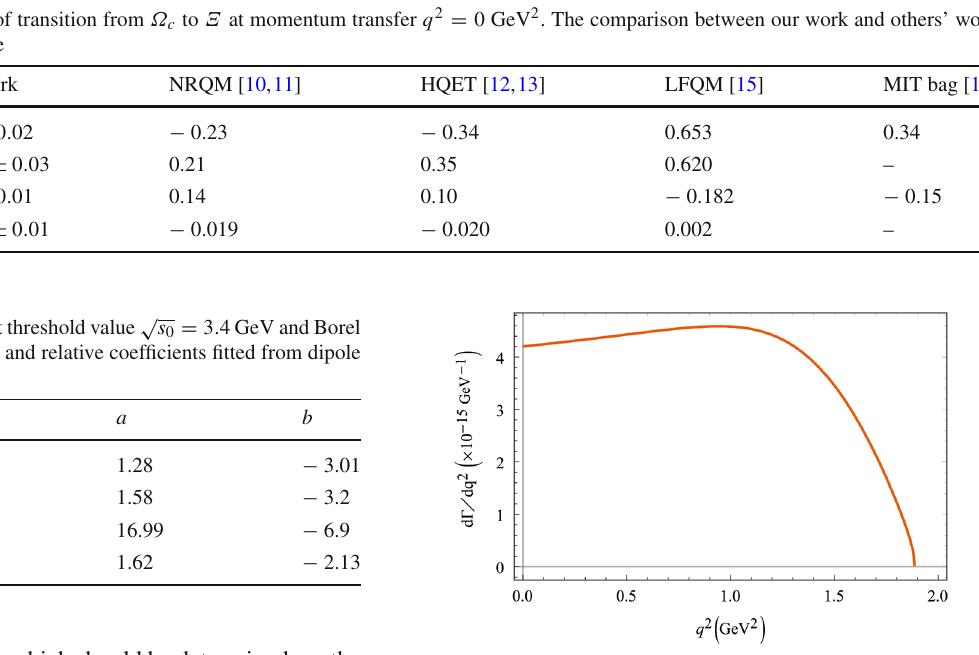
Table 1 The form factors of transition from Ω c to Ξ at momentum transfer q 2 = 0 GeV 2 . The comparison between our work and others’ work